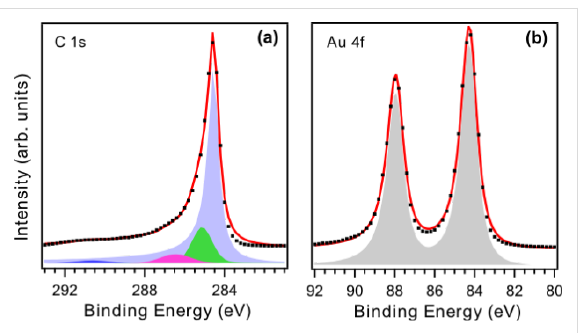
Figure 7: XPS core level spectra of C 1 s (a) and Au 4 f (b) recorded on 150 µm-long VA-CNTs decorated with 6 nm-diameter gold nanoparti- cles on top. A Shirley background has been subtracted, experimental data (black dots) and peaks resulting from a least-square fitting proce- dure (red lines). Fitting peaks of C 1 s (a): light blue for sp 2 carbon, green for sp 3 amorphous carbon, purple for C-O and dark blue for π -plasmon